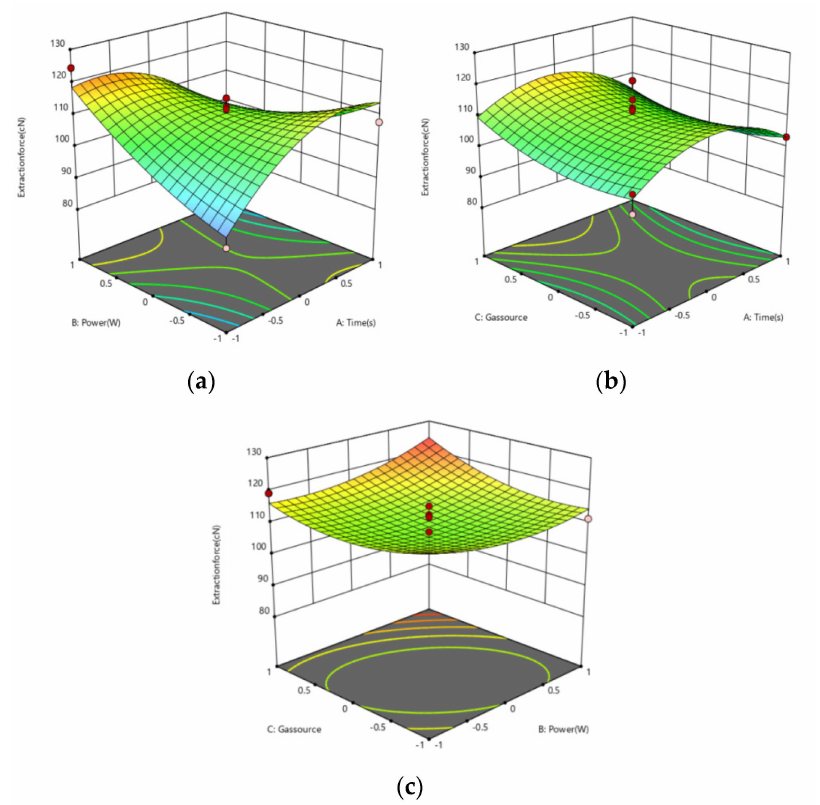
Figure 7. Response surface plot: Effect on extraction force of ( a ) power and time ( b ) gas and time ( c ) gas and